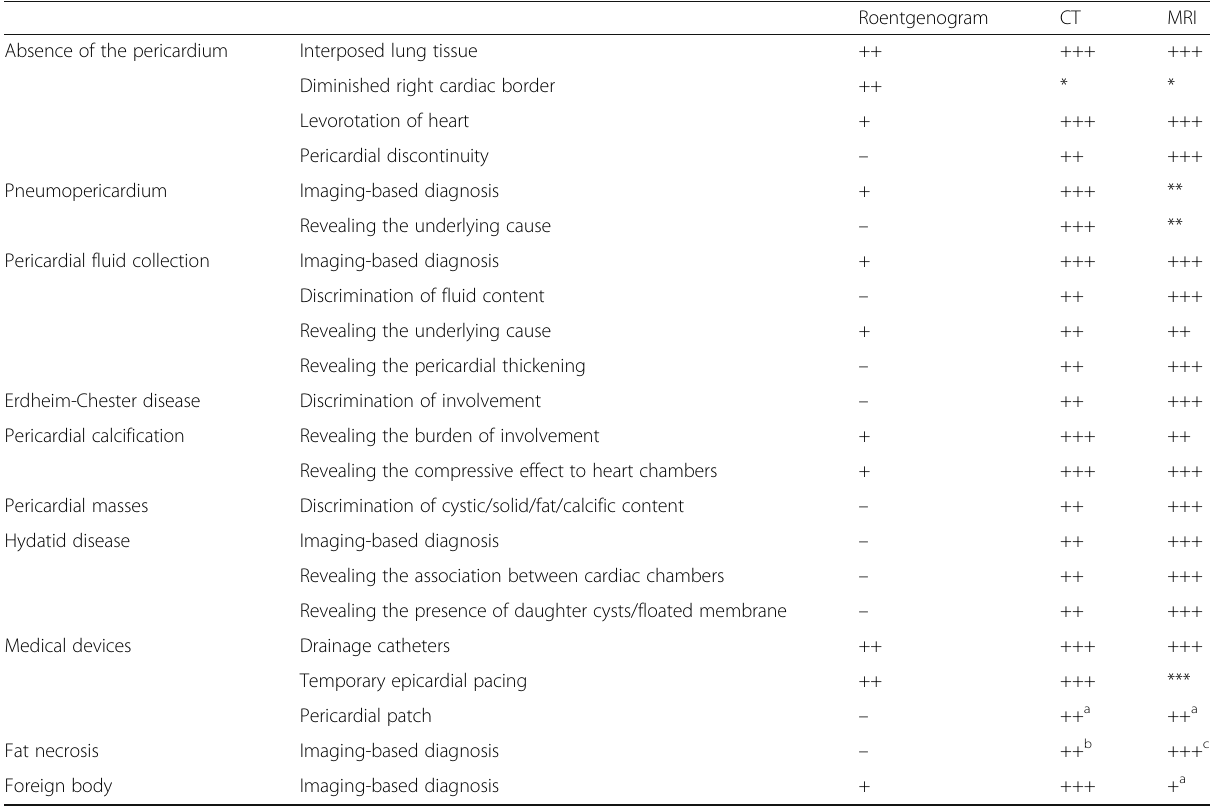
Table 1 The role of imaging modalities in various pericardial